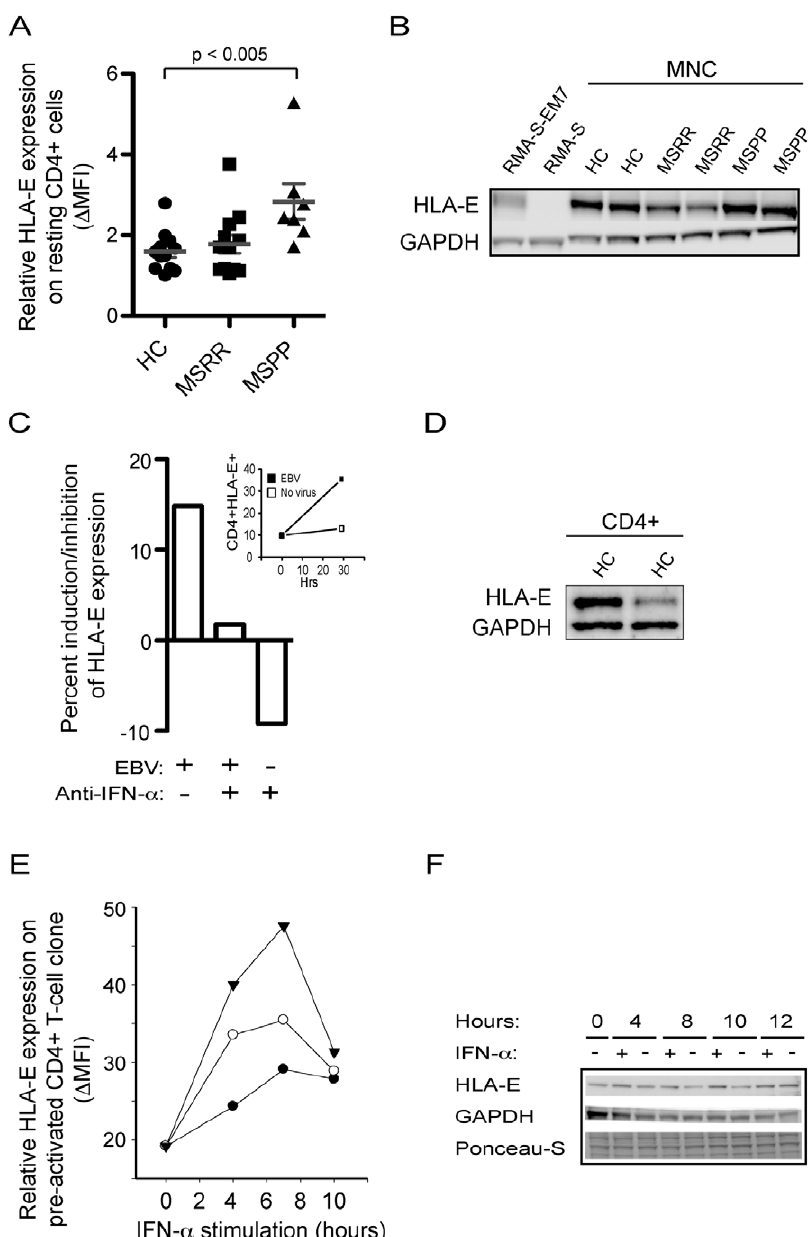
Figure 1. HLA-E expression. (A) Primary progressive MS patients have enhanced expression of HLA-E on CD4 + cells. Mononuclear cells from healthy controls (HC), relapsing-remitting MS patients (MS-RR) and primary progressive MS patients (MS-PP) were incubated with fluorophore- conjugated antibodies against HLA-E and CD4 and analysed by flow cytometry. Results are expressed as median of fluorescence intensity. (B) Expression of HLA-E on mononuclear cells from patients and controls. Western blot analysis of HLA-E expression on lysates from mononuclear cells of healthy controls and MS patients. Positive and negative control lysates are from RMA-S-EM7 and RMA-S cells. GAPDH is used as a loading control. Results are representative of two experiments. (C) EBV induces expression of HLA-E. Mononuclear cells were treated with EBV containing supernatant from B95-8 or medium in the presence or absence of neutralizing anti-IFN- a antibody. Results are expressed as induction/inhibition in percentage of uninduced cells by calculating [(MFI treated 2 MFI untreated )/MFI untreated ] 6 100%. Insert shows flow cytometric analyses of CD4 + HLA-E + on the mononuclear cells at 0 hr and 29 hrs incubation with EBV. Results are representative of 2 independent experiments. (D) Expression of HLA-E on CD4 + cells. Western blot analysis of HLA-E expression on lysates from CD4 + cells isolated from mononuclear cells by magnetic bead separation. GAPDH is shown as a loading control. (E) IFN- a induces surface-expression of HLA-E. A CD4 + T-cell clone was stimulated between 0 and 10 hours in the presence or absence of IFN- a . Cells were incubated in the absence (closed circles) or presence of 500 U/ml (open circles) or 100,000 U/ml of IFN- a (triangles). Cells were examined by flow cytometry and results expressed as D median fluorescence intensity ( D MFI) of HLA-E expression when incubated with anti-HLA-E antibody minus the MFI of an isotype control antibody. Results are representative of 5 independent experiments. (F) IFN- a induces expression of HLA-E. Cells were lysed at the indicated time and analyzed by Western blotting. Nitrocellulose was probed with anti-HLA-E and as a loading control an anti-GAPDH antibody. Ponceau-S staining of the nitrocellulose indicates even transfer of proteins between the lanes.